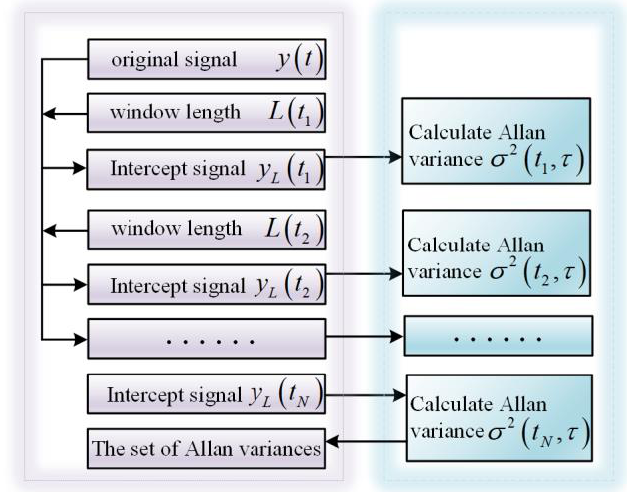
Figure 1. DAVAR algorithm flow char.